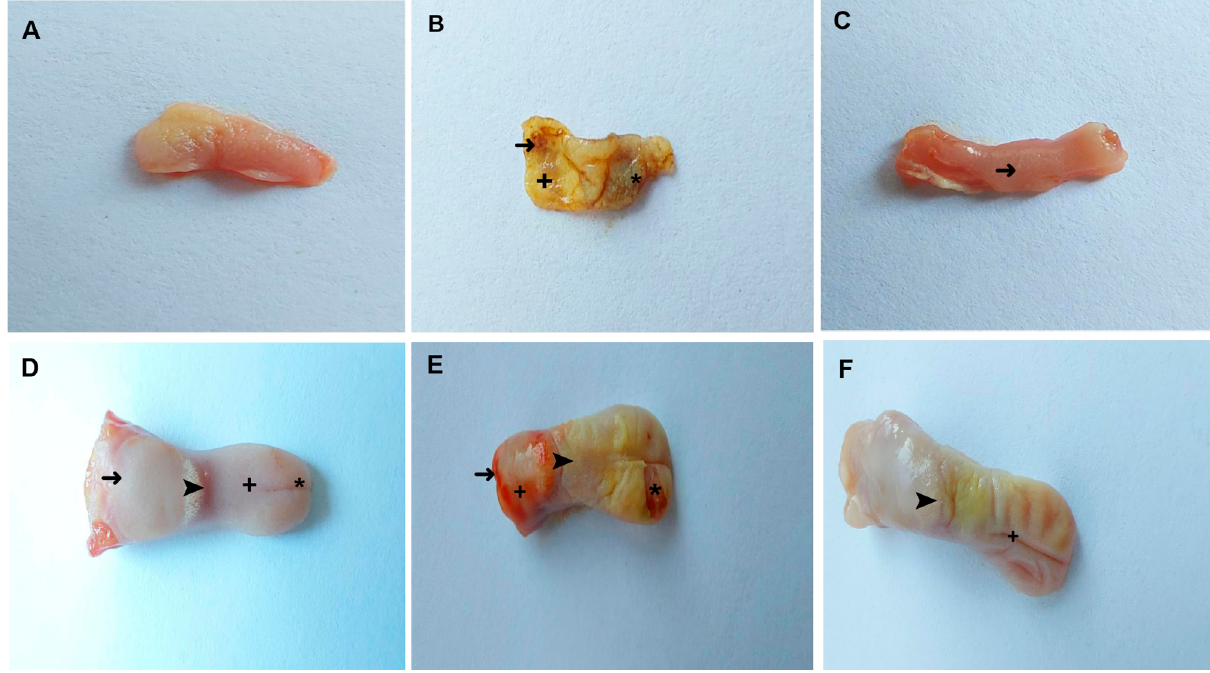
Figure 1- Macroscopic evaluation of the inner cheek and tongue tissues in the groups. A . Normal healthy inner cheek tissue of the healthy group. B . Inner cheek tissue of the MTX group. Swelling ( → ); severe hemorrhage and hyperemia (+); ulcerated areas (*). C . Inner cheek tissue of the TMTX group. Moderate swelling and hyperemia ( → ) D . Normal tongue tissue of the healthy group. Tongue body (+); tongue tip (*); tongue root ( → ); papillae ( ➤ ). E . Tongue tissue of the MTX group. The entire tongue is swollen; muscle hyperemia due to loss of the full-thickness epithelial layer on the tip (*); complete loss of papillae ( ➤ ); hemorrhage ( → ); hyperemia in the root (+). F . Tongue tissue of the TMTX group. Moderate swelling; indistinct papillae ( ➤ ); moderate hyperemia on the body and tip